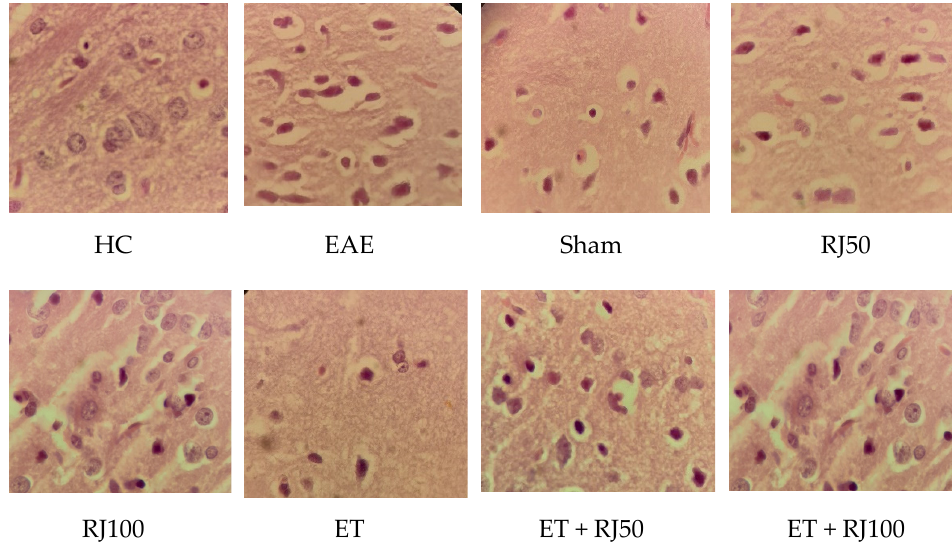
Figure 1. Histopathological analyses of hippocampus. Healthy control (HC); experimental autoim- mune encephalomyelitis (EAE); 50 mg/kg royal jelly (RJ50); 100 mg/kg royal jelly J (RJ100); exercise training (ET); exercise training+ 50 mg/kg royal jelly (ET + RJ50); exercise training+ 100 mg/kg royal jelly (ET + RJ100).